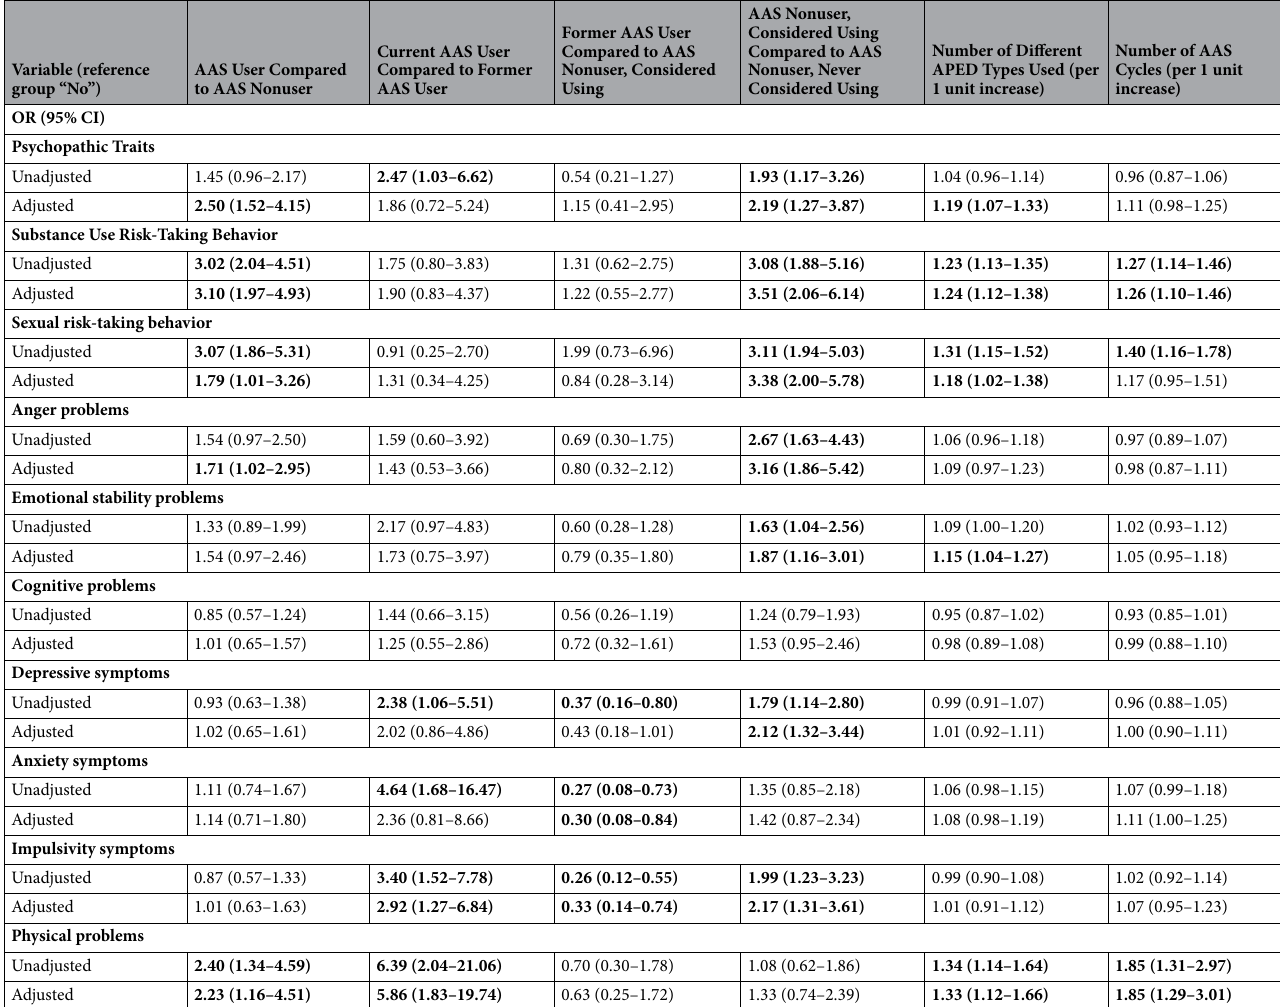
Table 4. Associations of AAS Use, APED Variety, and Number of Cycles with Traits of Interest. Results with CI excluding OR = 1 (no difference) are